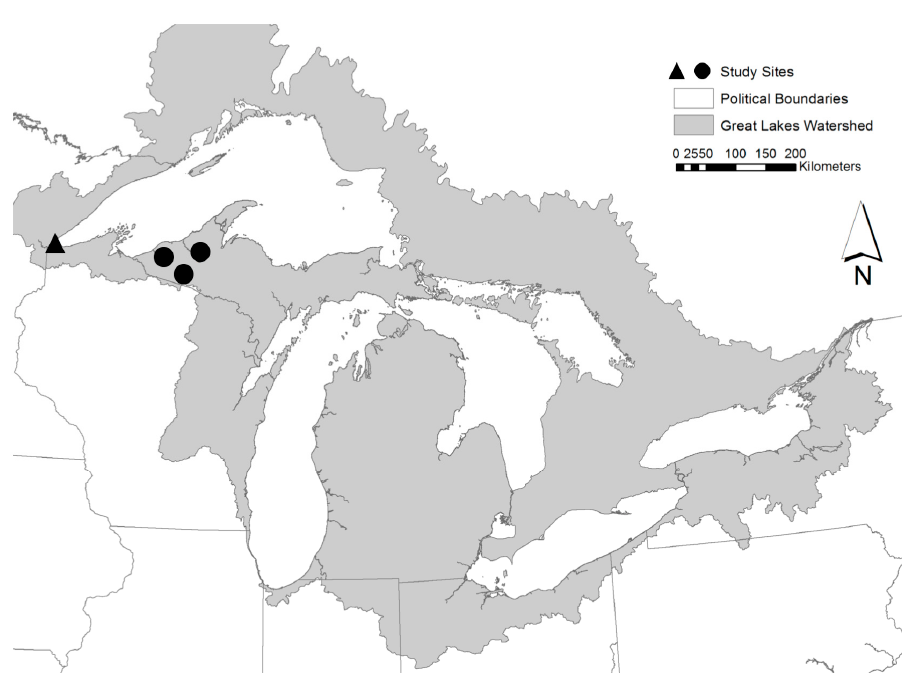
Figure 1. Map of the Great Lakes region with the three study locations in the Ottawa National Forest ( ), in the western Upper Peninsula of Michigan, and the one study location in the Superior Municipal Forest ( (cid:78) ), in northwestern Wisconsin. The shaded region is the Great Lakes Watershed with United States and Canadian boundaries.